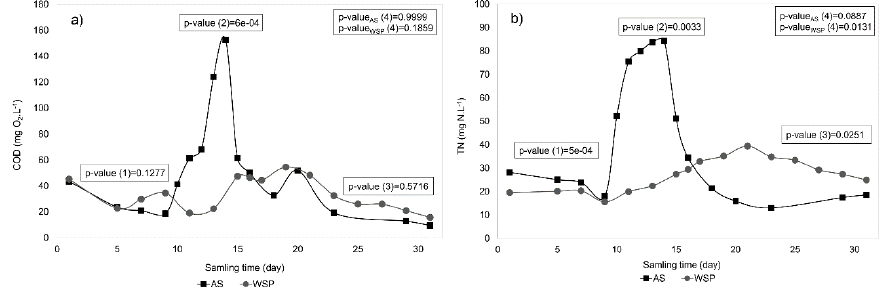
Figure 4. The effluent pollutant levels of the CAS and WSP with the p -value of the hypothetical tests during the peak scenario (( a ): COD, ( b ): TN).